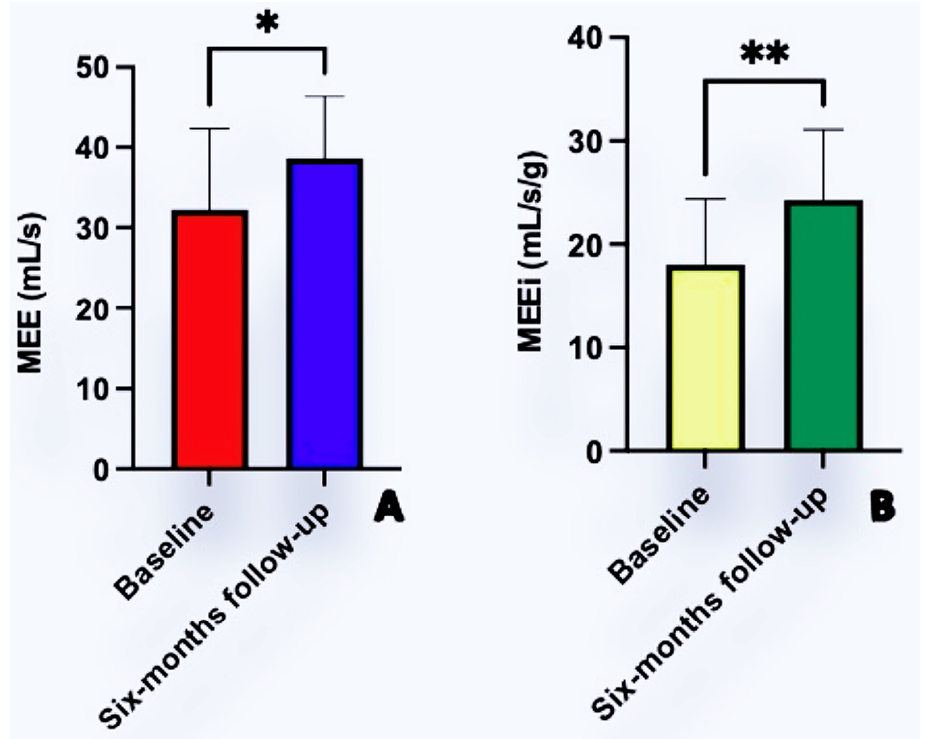
Figure 3. Improvements of Myocardial Mechano-Energetic Efficiency (MEE; Panel ( A )) and Mechano- Energetic Efficiency index (MEEi; Panel ( B )) after six months of CCM therapy. * = p < 0.05; ** = p < 0.001.